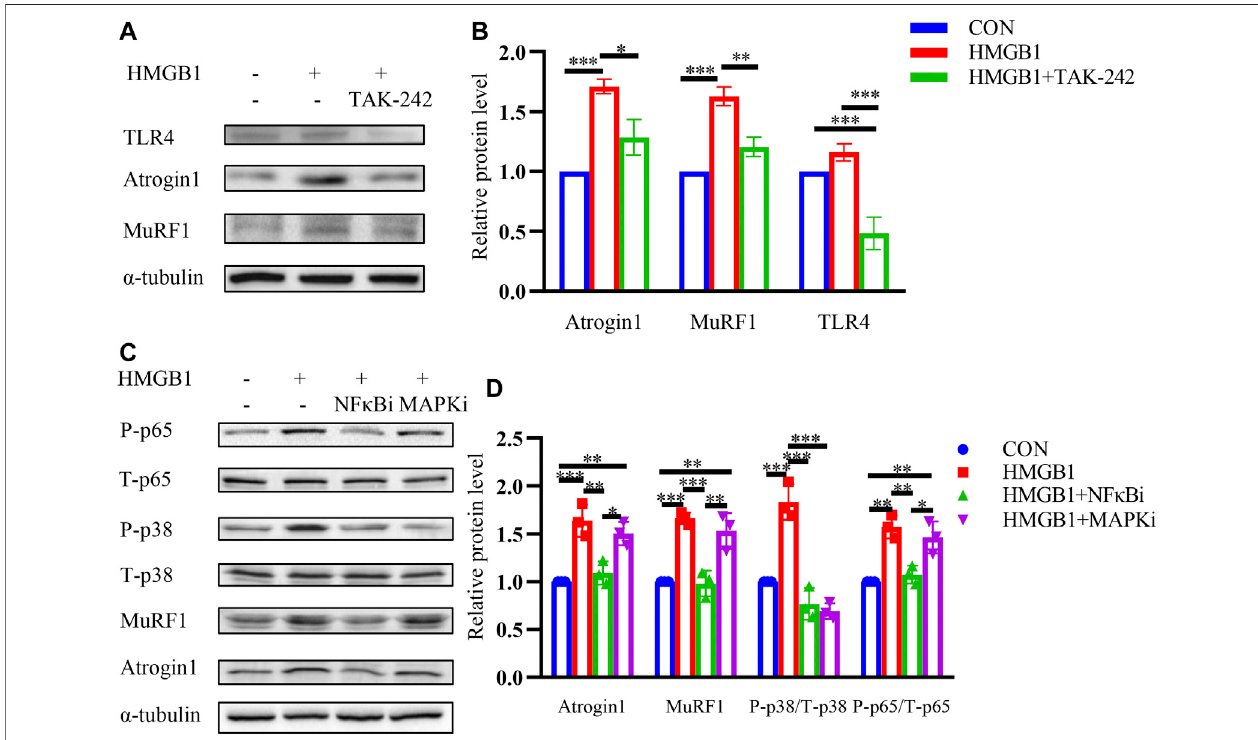
FIGURE 4 | HMGB1 induces muscle wasting through TLR4/NF- κ B signaling pathway. (A) C2C12 myotubes were pretreated with inhibitor for TLR4 (TAK-242) followed by incubation with HMGB1. The expression of Atrogin1 and MuRF1 was determined by western blot. (B) Densitometric quanti fi cation of the Atrogin1 and MuRF1 signal relative to the α -tubulin signal. (C) C2C12 myotubes were pretreated with inhibitors for NF- κ B and MAPK pathways followed by incubation with HMGB1. The expression of Atrogin1, MuRF1, phosphorylated p65 and phosphorylated p38 was determined by western blot. (D) Densitometric quanti fi cation of the Atrogin1 and MuRF1 signal relative to the α -tubulin signal, phosphorylated p65 relative to the total p65 signal and phosphorylated p38 signal relative to the total p38 signal.